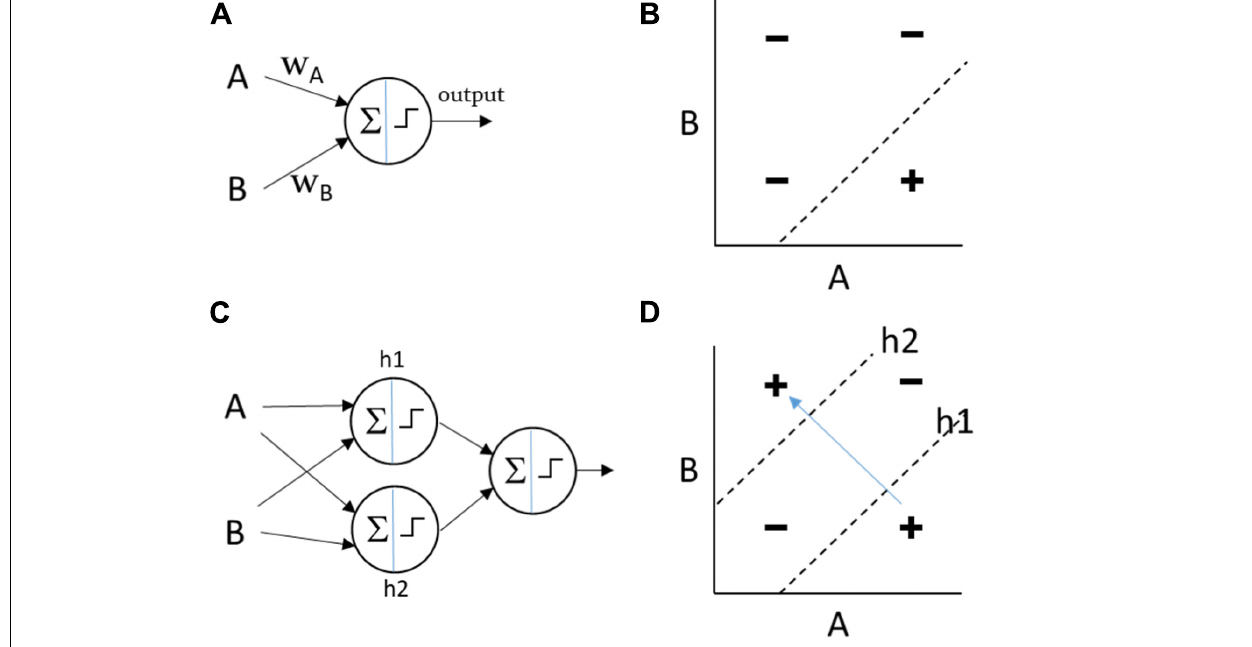
FIGURE B3 | Shallow and deep computations. (A) A Perceptron of two inputs calculates an output that is a non-linear weighted sum of its inputs. (B) The Perceptron can represent any linearly separable function, such as this example, AND(A,NOT(B)). (C) The multi-layer Perceptron utilises “hidden” nodes to calculate intermediate functions which are fed forward to the output node. This can calculate any linearly or non-linearly separable function of its inputs. (D) In this example, h1 calculates AND(A,NOT(B)) and h2 calculates AND(NOT(A),B). The output node can calculate OR(h1,h2) such that the network as a whole represents the non-linearly separable function XOR(A,B). In a non-linearly separable function, moving between different positive regions (variation within the class without visiting regions that are not in the class) cannot be achieved by linear movements in the input space and instead requires “jumps” or coordinated “collective action” (simultaneous discontinuous changes in multiple